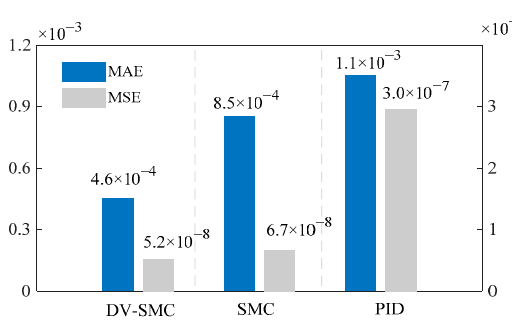
Figure 11. Sinusoidal tracking outcomes.